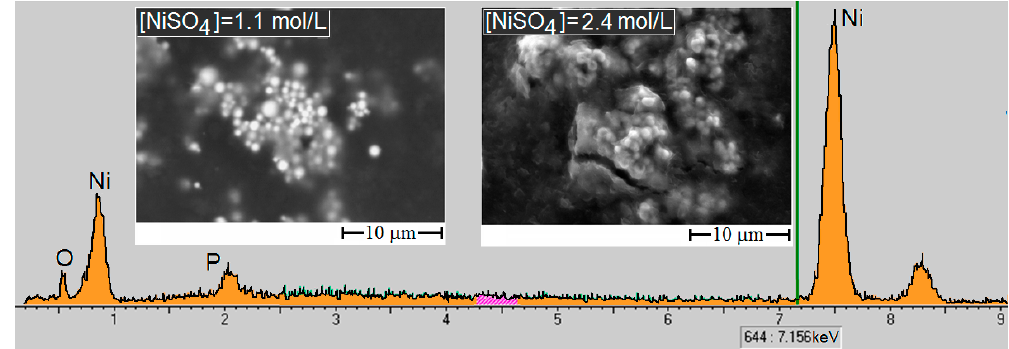
Figure 6. Scanning electron microscopy (SEM) images and energy dispersion analysis (EDA) histograms of the Ni / р HEMA-gr-PVP composite (H ЕМ A:PVP:S ORS = 80:20:25 mass parts; рН = 8).